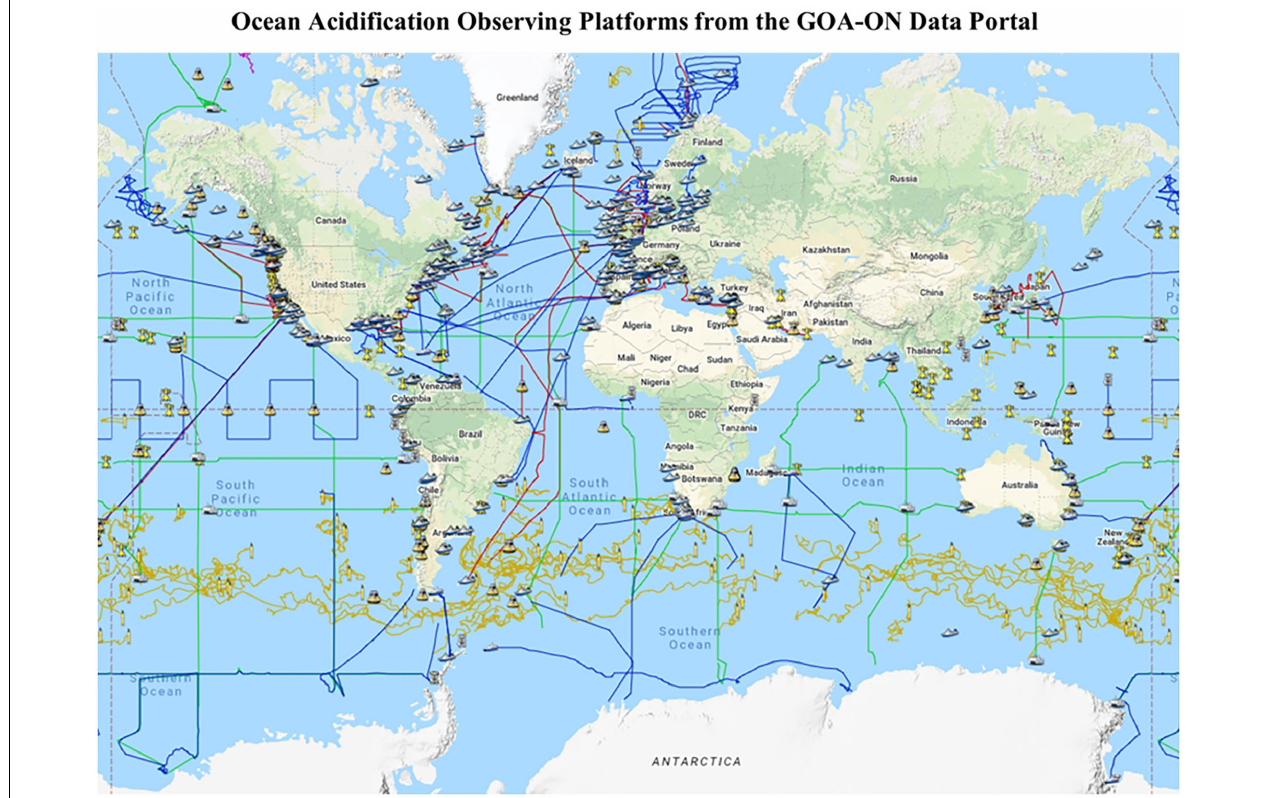
FIGURE 11 | Visualization of ocean acidification data and data synthesis products being collected around the world from a wide range of sources, including moorings, research cruises, and fixed time series stations. Figure source GOA-ON Data Portal